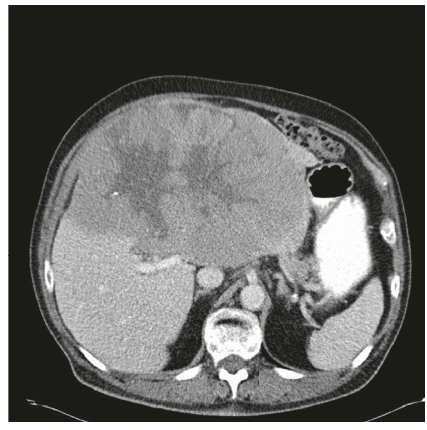
Figure 1: Abdominal CT scan at diagnosis. Figure 2: CT scan 24 months after the